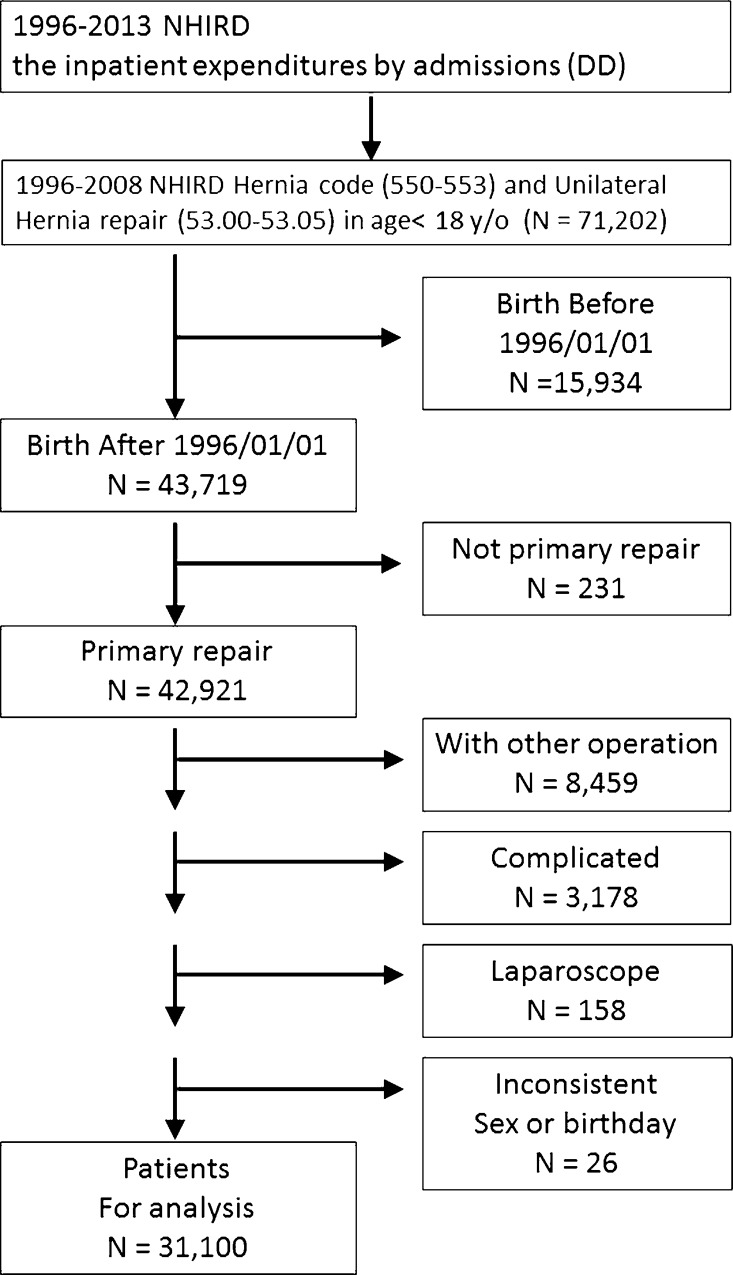
Study flow chart.